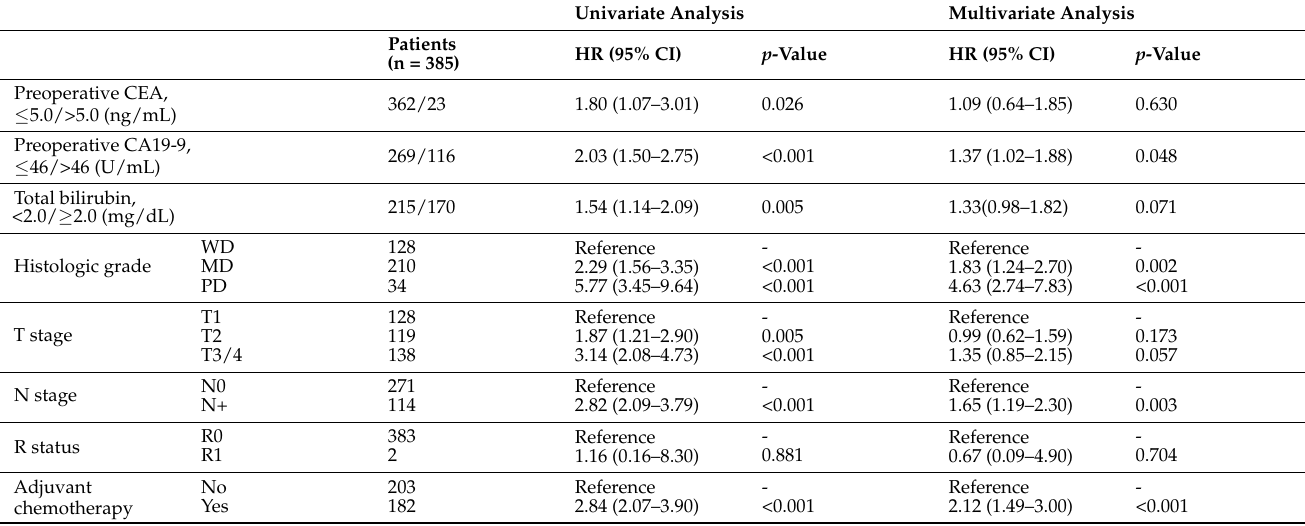
Table 3. Prognostic factors for overall survival (CA 19-9 level cut-off: 46